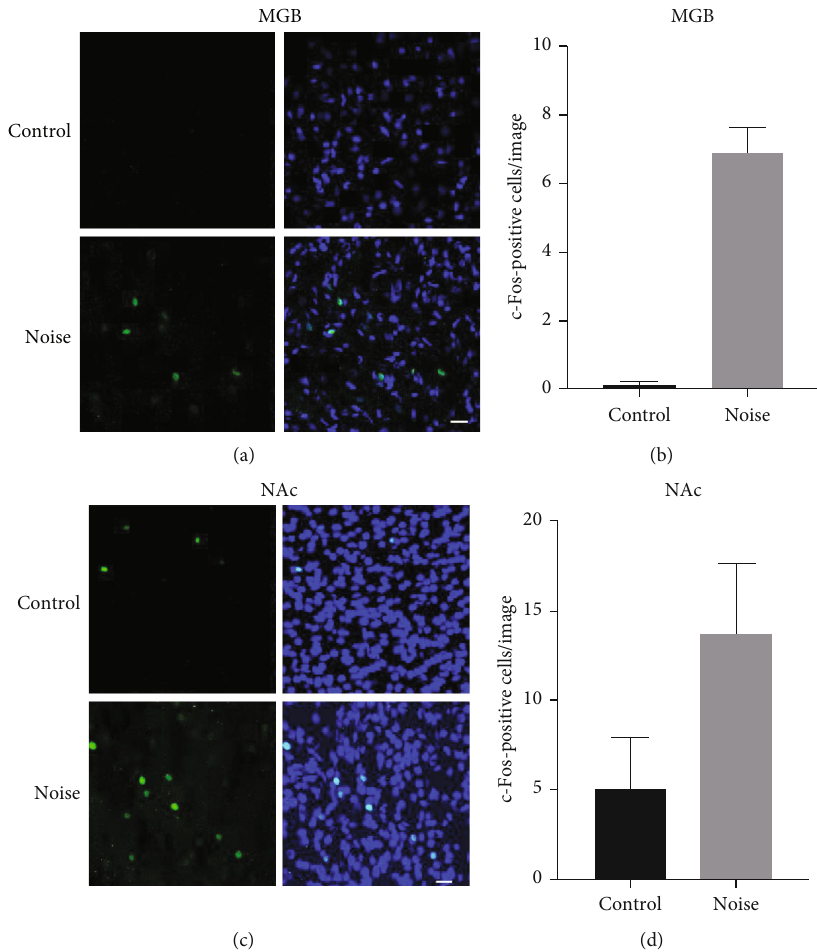
Figure 3: The c-Fos expression detected in the medial geniculate nucleus (MGN) and the nucleus accumbens (NAc) in rats. The nuclei were stained for c-Fos (green) and were visualized with TO-PRO-3 iodide (blue) (63x magni fi cation oil immersion lens with numerical aperture of 1.4). Marker: 10 μ m. (a, b) c-Fos has very few expressions in the MGN of the rats in the control group but was signi fi cantly expressed in the MGN of rats in the noise group. The c-Fos-positive cell counting showed signi fi cant deference (Student ’ s t -test, P < 0 : 05 ). (c, d) c-Fos expression increased obviously in the noise group than in the control group. The number of c-Fos-positive cells of the NAc in the noise group increased signi fi cantly compared with that in the control group (Student ’ s t -test, P < 0 : 05